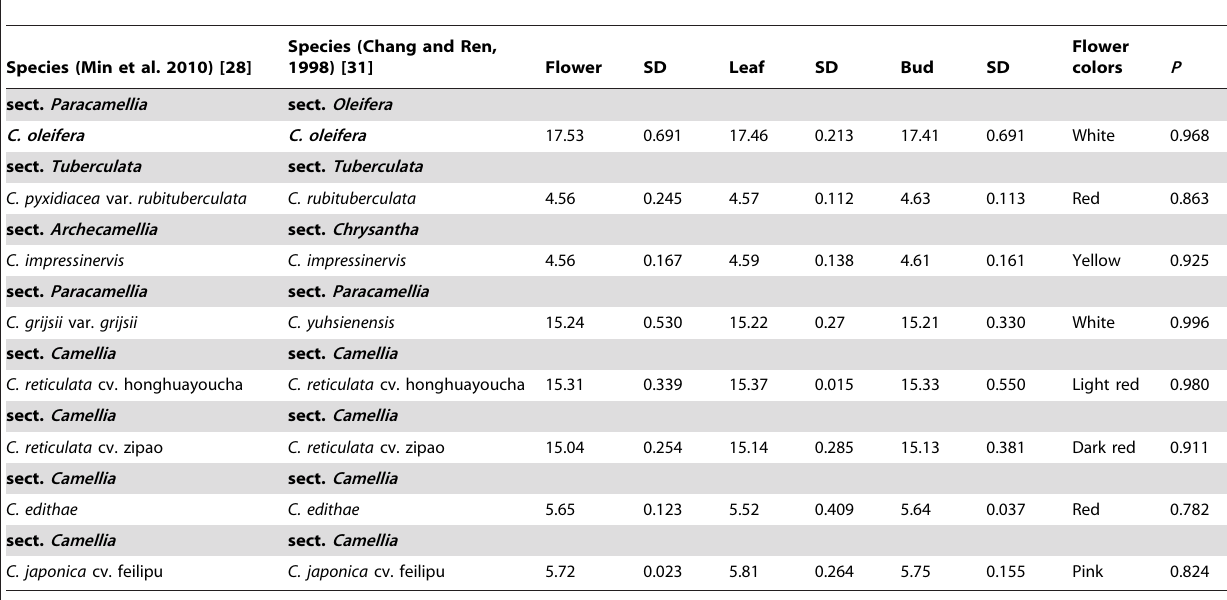
Table 1. Comparisons of nuclear DNA amount (2C, pg) estimated with flow cytometry in different tissues of the eight species in the genus Camellia .